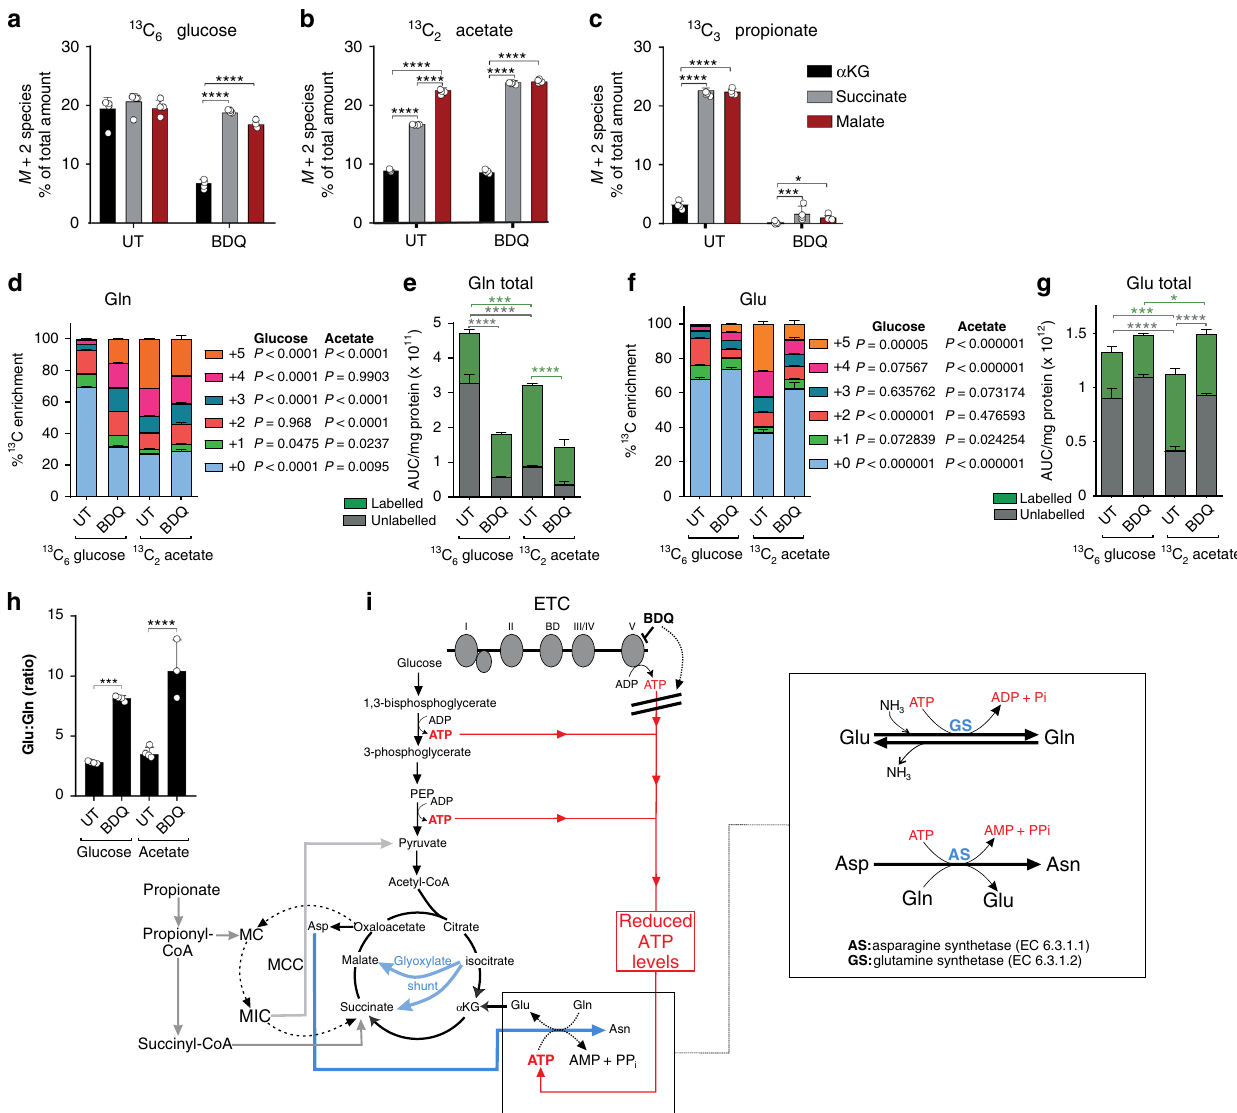
Fig. 4 BDQ treatment leads to dysregulation of the glyoxylate shunt and reduced total glutamine. The percent abundance of M + 2 isotopologues of alpha-ketoglutarate ( α KG), succinate and malate from ( a ) 13 C 6 glucose, ( b ) 13 C 2 acetate and ( c ) 13 C 3 propionate as the 13 C tracer. The % 13 C enrichment and carbon isotopologue distribution (CID) of ( d ) glutamine (Gln), ( f ) glutamate (Glu) as well as ( e ) total Gln and ( g ) Glu levels and the ( h ) Glu:Gln ratio. ( i) A diagram depicting bedaquiline ’ s (BDQ ’ s) effect on Gln is also shown. Mean + / − standard error of the mean (SEM) of at least three replicate extracts is indicated. One representative experiment is shown, with the experiment being repeated a minimum of two times. A two-way ANOVA and Tukey ’ s multiple-comparison test were used for the statistical analysis. UT - untreated. n = 4 biologically independent samples. * P < 0.05, *** P < 0.001, **** P <